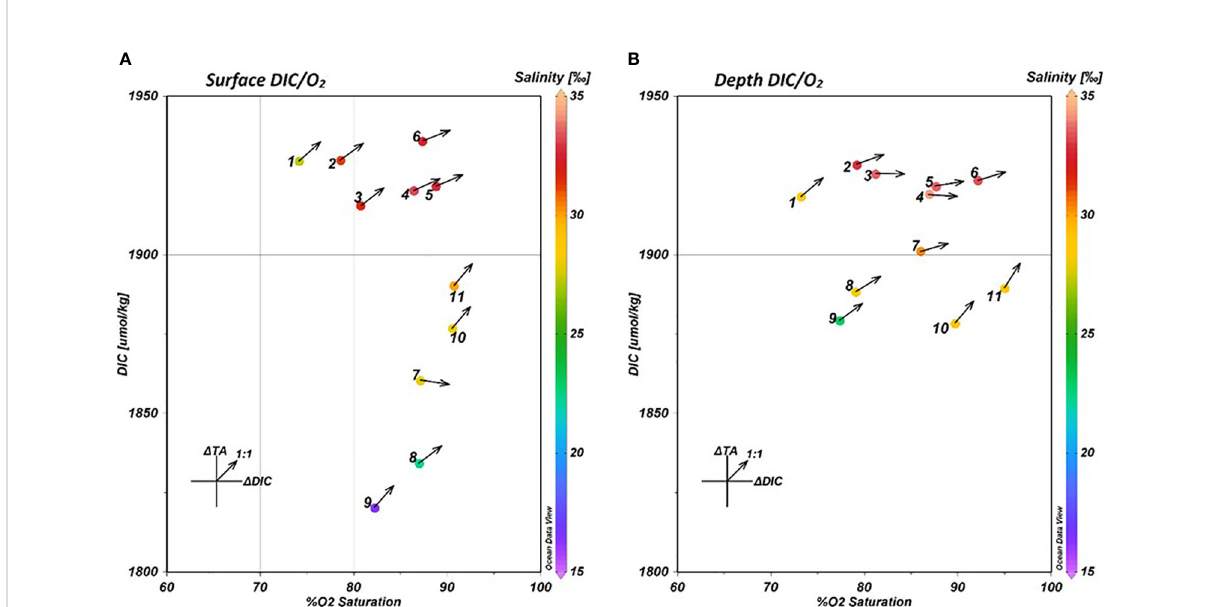
FIGURE 7 DIC-O2 Saturation plots for surface (A) and depth (B) measurements at the 11 in-pond sampling stations. The color bar indicates the mean salinity observed at each plotted station and depth. The arrows plotted from each point indicate the slope of the fi tted curve of the D TA/ D DIC relationship at that station and